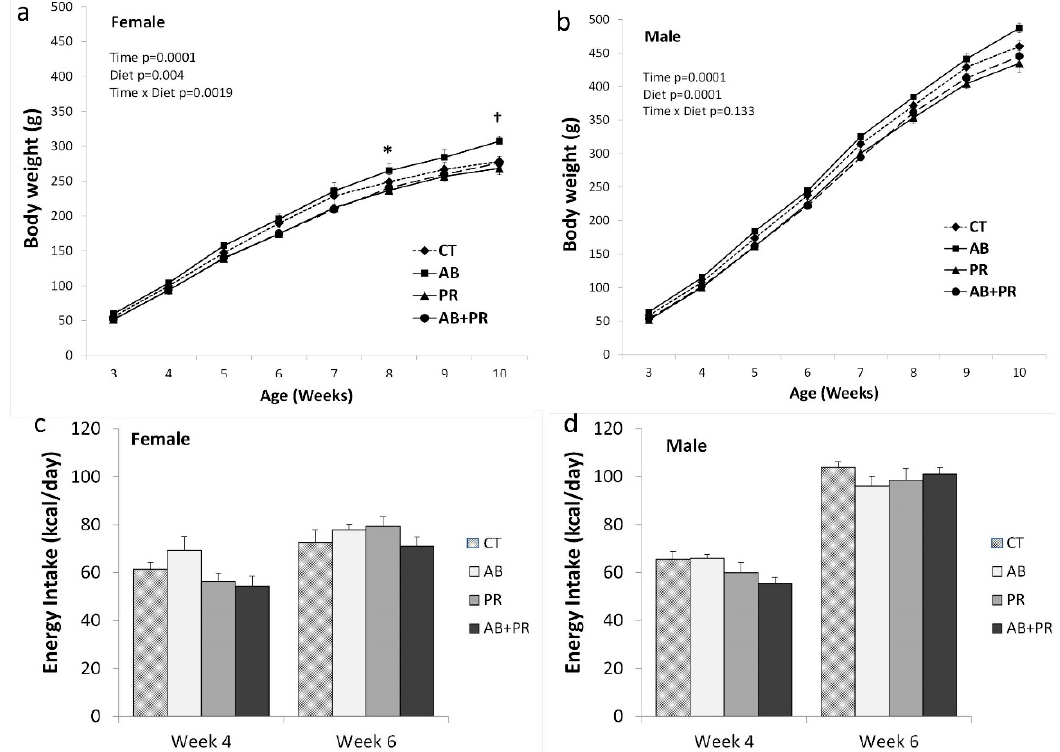
Figure 1. ( a ) Female o ff spring body weight; ( b ) male o ff spring body weight; ( c ) female o ff spring energy intake; ( d ) male o ff spring energy intake. Values are mean ± SEM ( n = 10–13 / group). * AB significantly di ff erent from PR ( p = 0.01) and AB + PR ( p = 0.027). † AB significantly di ff erent from PR ( p = 0.004) and AB + PR ( p = 0.029) with a trend compared to CT ( p = 0.077). Significant diet e ff ect for male body weight is AB heavier than PR ( p = 0.0001) and AB + PR ( p = 0.001). CT: control; AB: antibiotic; PR: prebiotic; AB + PR: antibiotic plus prebiotic.